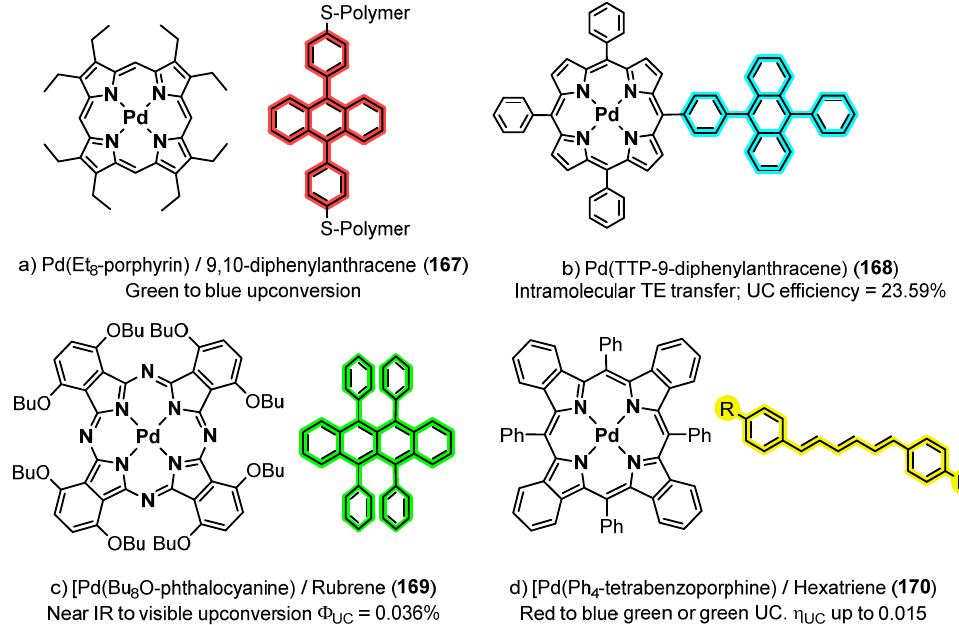
Figure 44. Representative examples of Pd-porphyrin complexes as photosensitizers for upconversion in organic substrates. Adapted from [146 − 151].